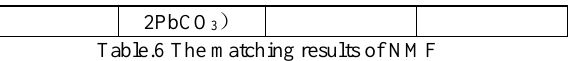
Table.6 The matching results of NMF